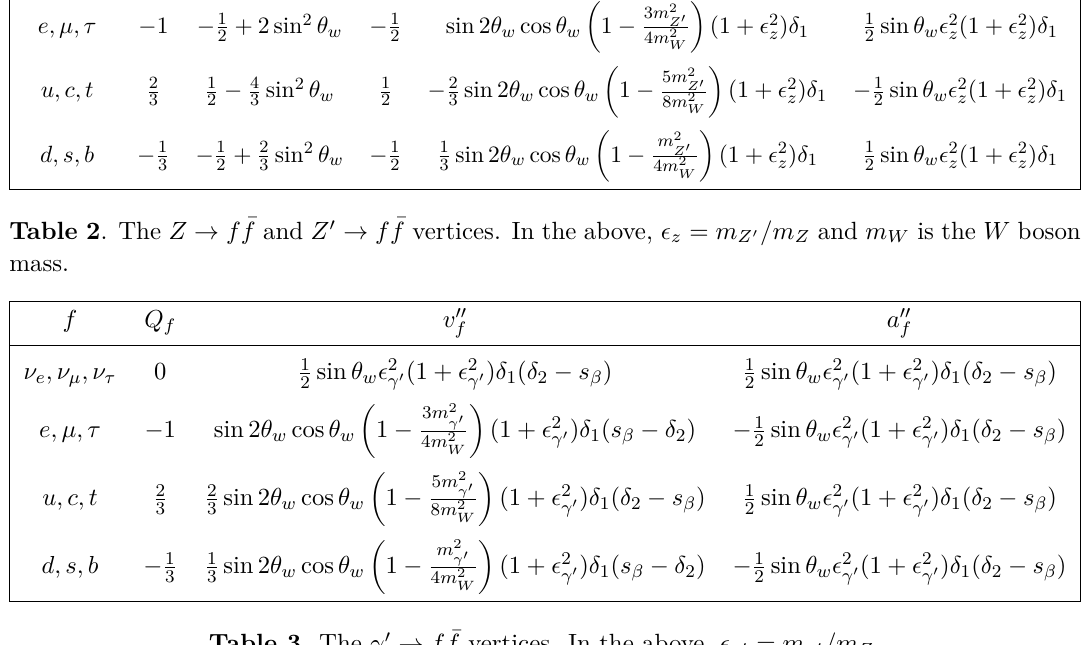
Table 3 . The γ 0 → f ¯ f vertices. In the above, (cid:15) γ 0 = m γ 0 /m Z